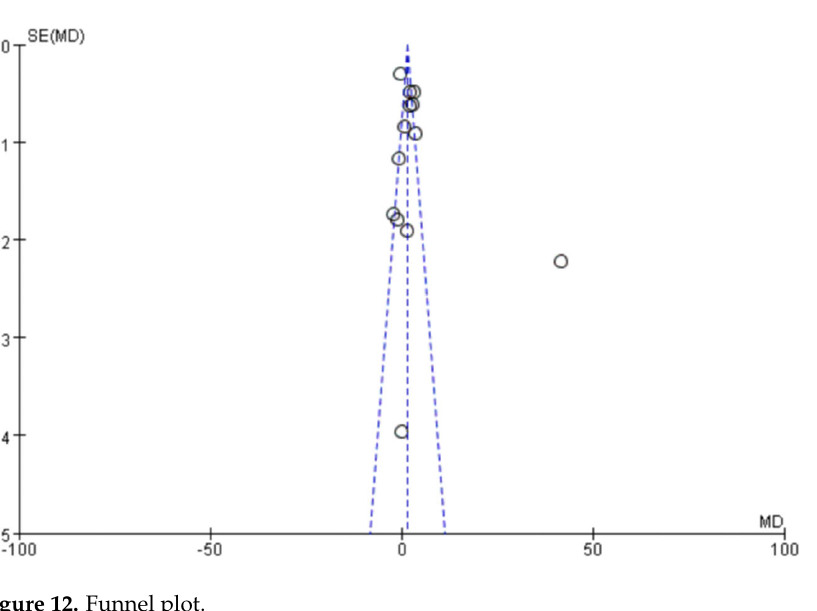
Figure 12. Funnel plot.